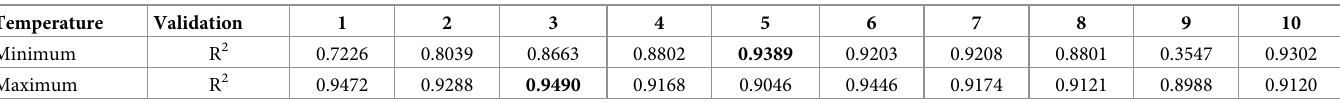
Table 1. Results for minimum and maximum temperature from the tenfold-cross validation. The temperatures highlighted (in bold) identify the best